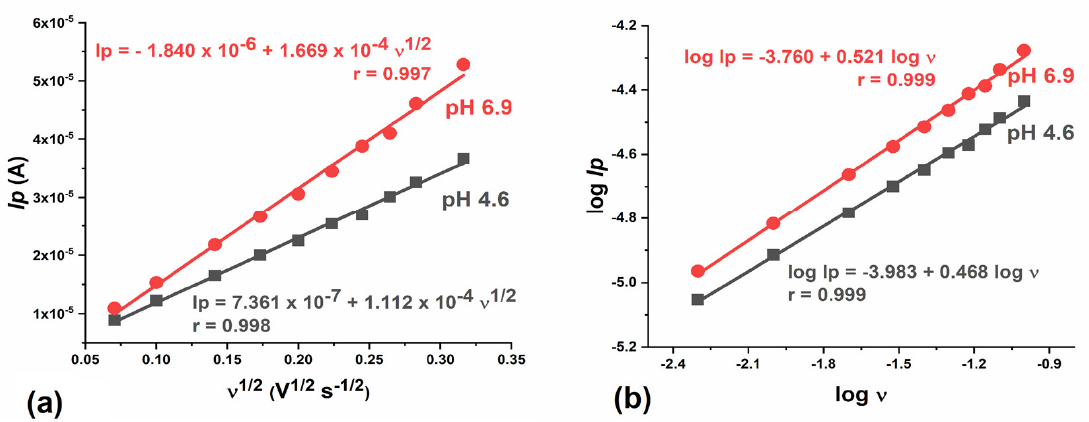
Figure 3. The effect of scan rate on the peak current of oxidation peak A1 peak. ( a ) Plot of I p,A1 vs. ν 1/2 ; ( b ) Plot of log I p vs . log ν. pH = 4.6 ( ── ), pH = 6.9 ( ── ).